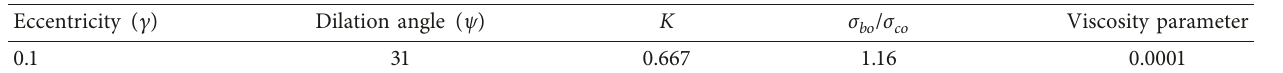
Table 2: Concrete damage parameter.